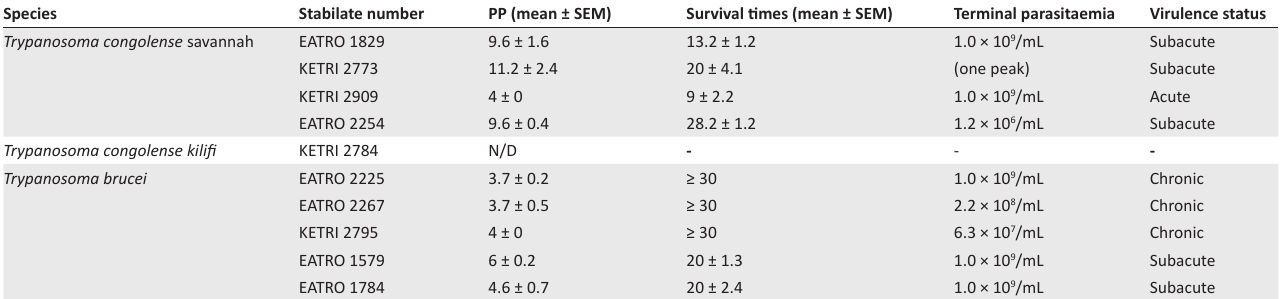
TABLE 2: Variations in pre-patent, survival times and terminal parasitaemia of mice infected with Trypanosoma congolense and Trypanosoma brucei isolates. Species Stabilate number PP (mean ± SEM) Survival times (mean ± SEM) Terminal